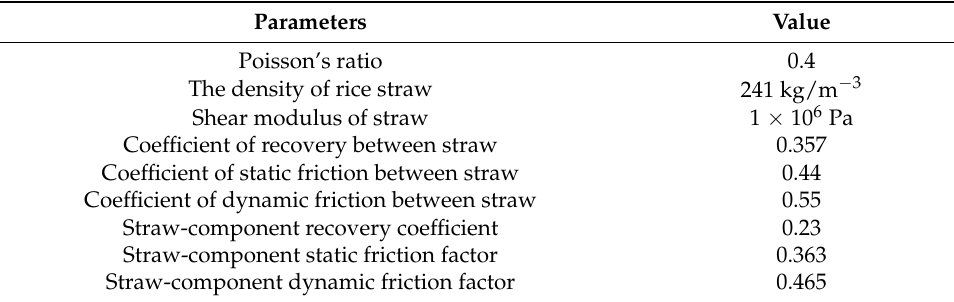
Figure 6. Simulation of the straw feeding movement process. Table 1. Physical parameters. Table 1. Physical